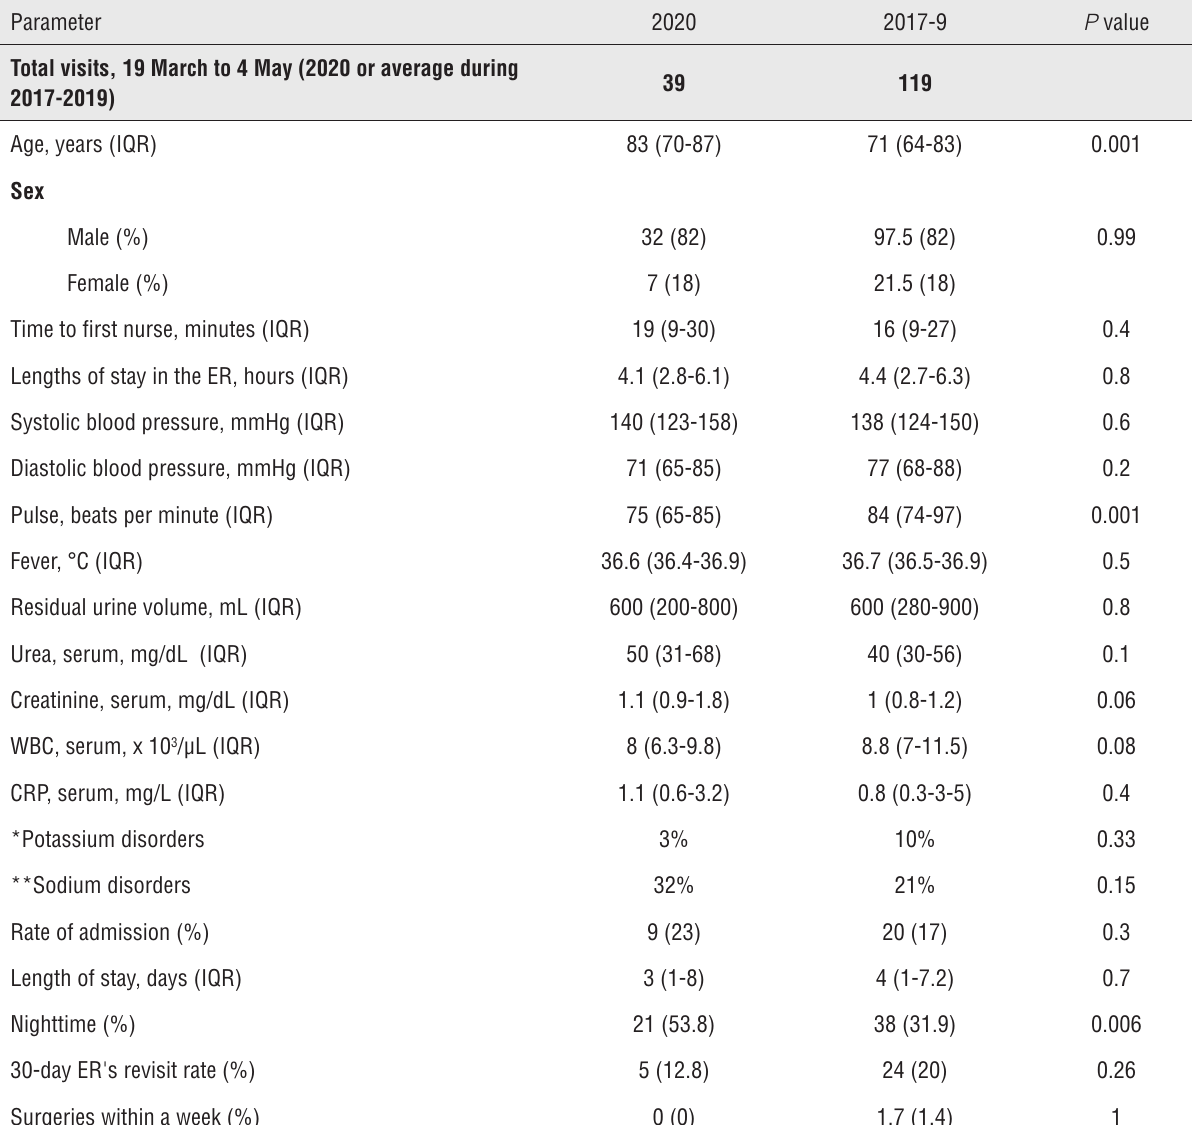
Table 3 - Urinary